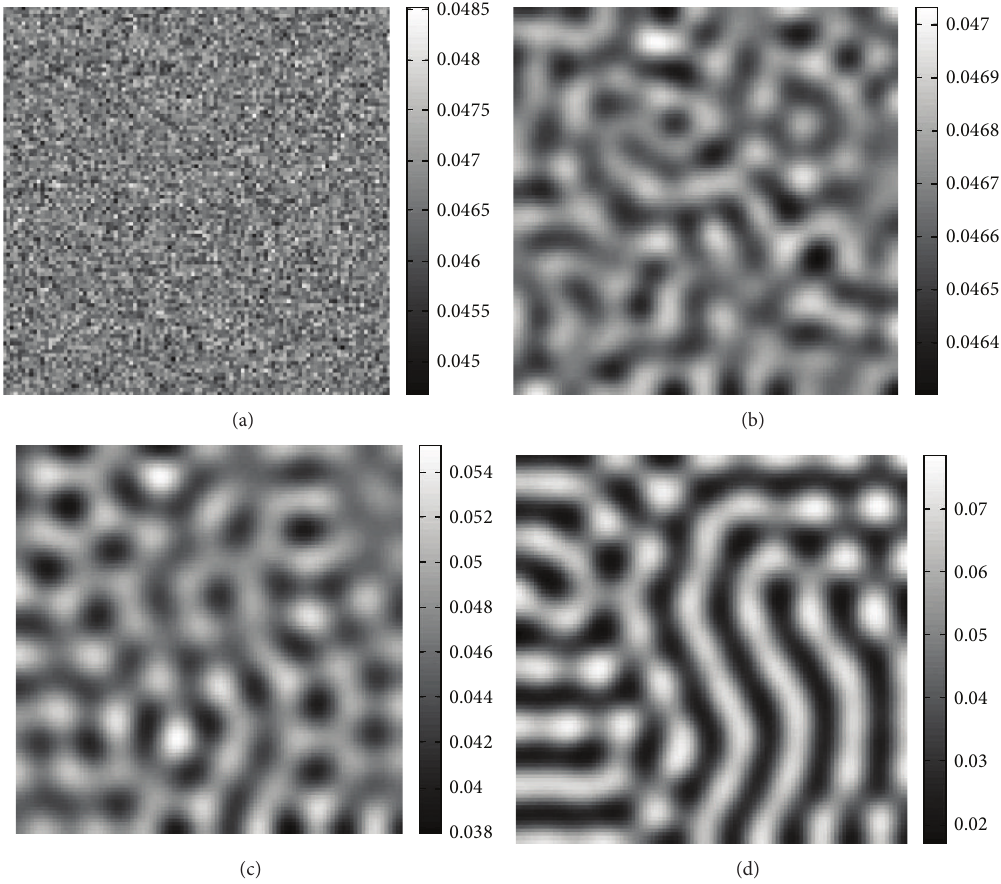
Figure 8: Spatiotemporal pattern of the prey 𝑢 of model (3) with 𝑐 1 = 1.07 and 𝑞 1 = 0.2 ; the initial condition is the random initial distribution around the steady state (𝑢 ∗ 1 , V ∗ 1 ,0) = (0.04667, 0.30333, 0) . Iterations: (a) 0 , (b) 10000 , (c) 100000 , and (d) 300000 .